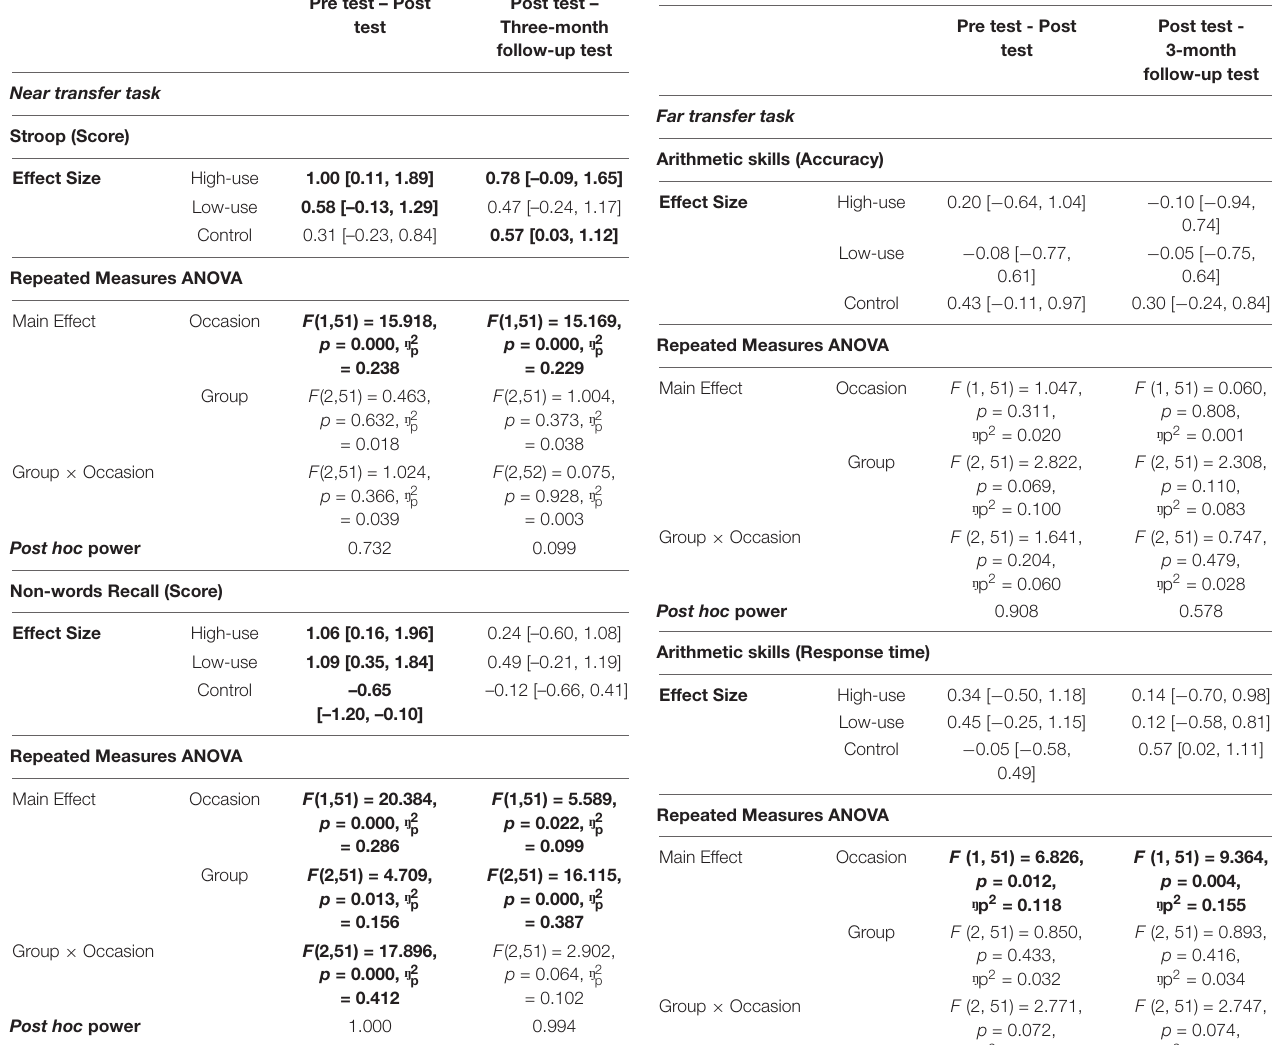
TABLE 11 | ANOVA analysis and effect sizes of individual tasks in Experiment 2. TABLE 12 | ANOVA analysis and effect sizes of far transfer arithmetic skills task in Experiment